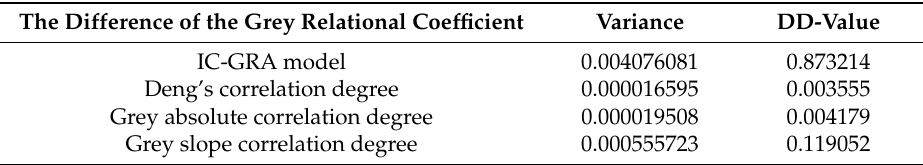
Table 2. The discriminability analysis of the grey relational coefficient. The Difference of the Grey Relational Coefficient